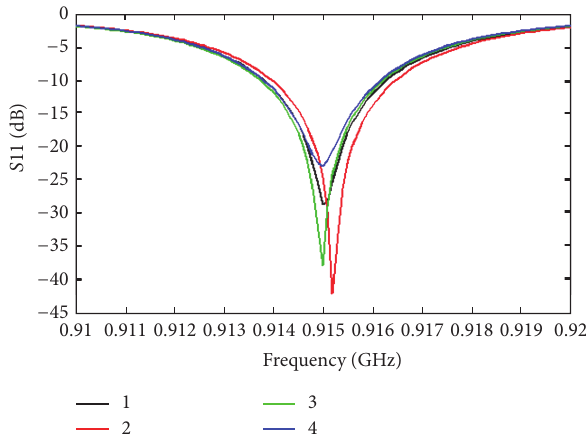
Figure 22: Return loss 𝑆11 of each 3D spherical antenna (Table 8).